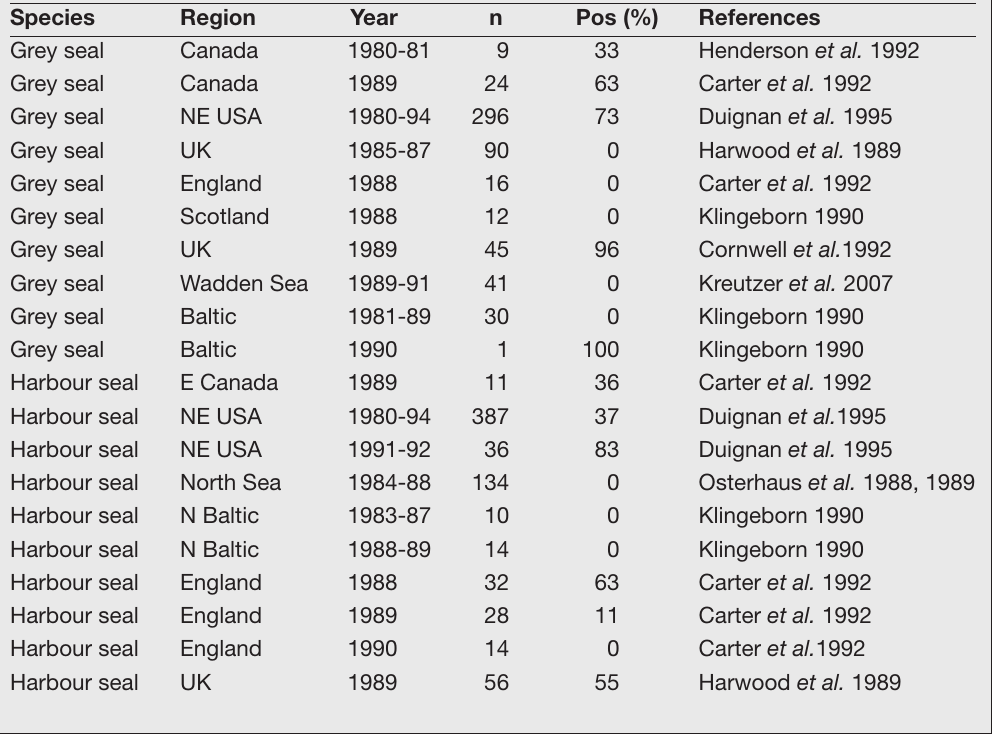
Table 2. Indications of exposure to PDV infection in seal populations at temperate